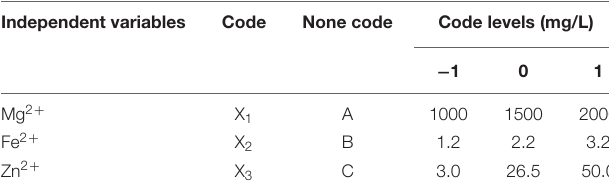
TABLE 1 | Levels of the code values and none code values based on single factor (ion)